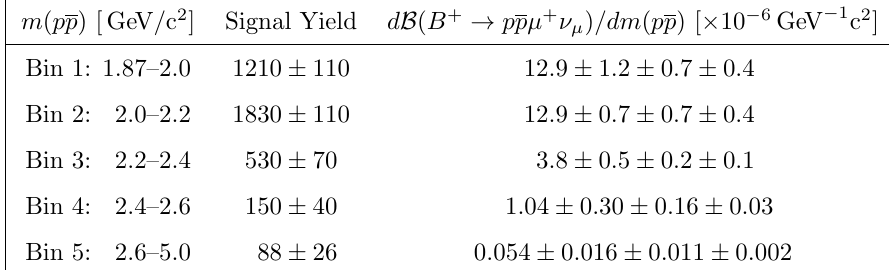
Table 3 . Number of observed B + ! pp(cid:22) + (cid:23) (cid:22) candidates and di(cid:11)erential branching fraction in each bin of m ( pp ). The uncertainties on the signal yields are statistical only. For the di(cid:11)erential branching fractions the (cid:12)rst uncertainties are statistical, the second systematic and the third from the uncertainties on the branching fractions of the normalisation